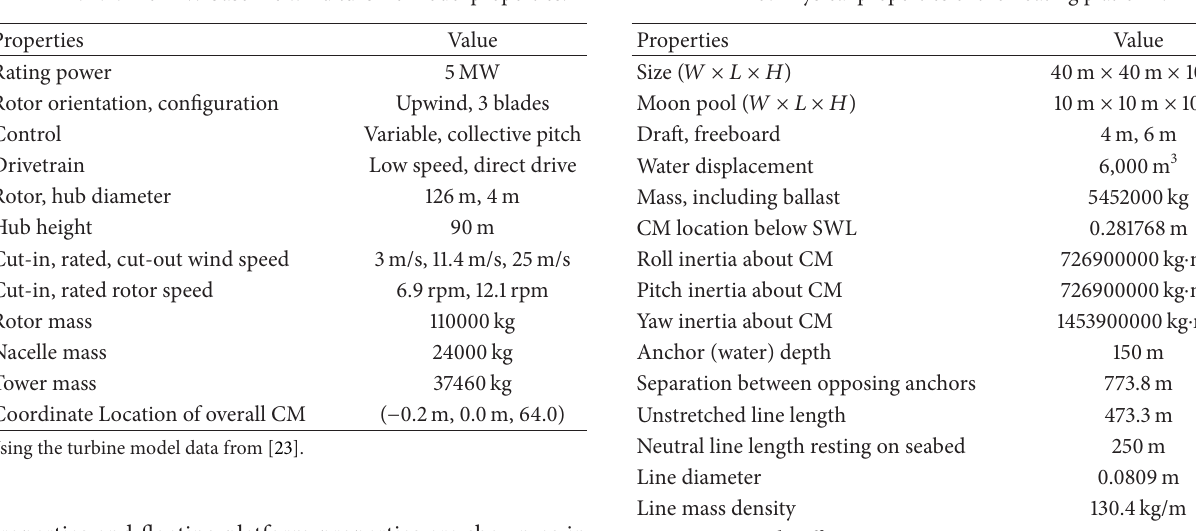
Table 2: NREL 5 MW baseline wind turbine model properties. Table 3: Physical properties of the floating